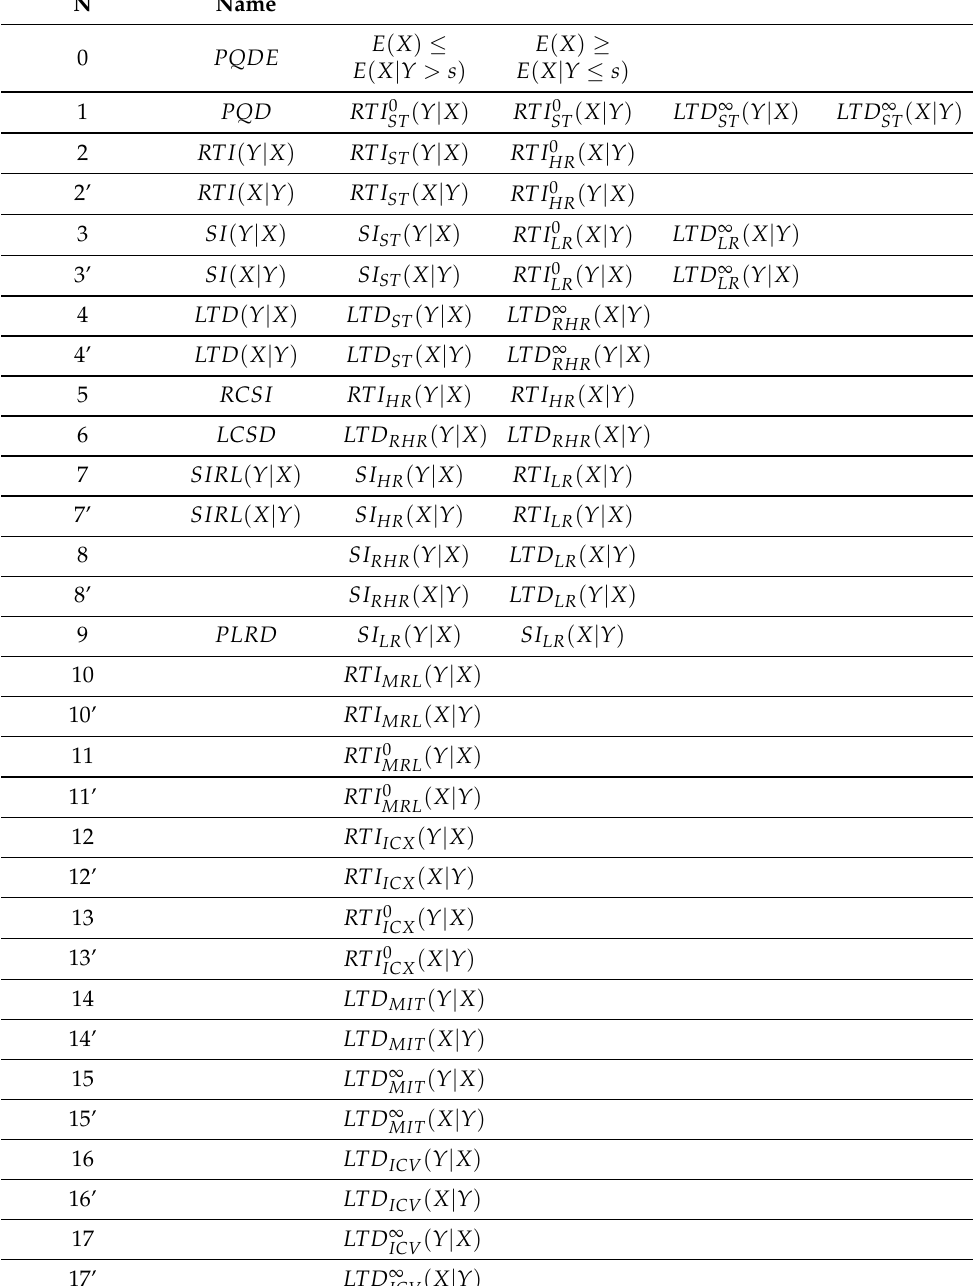
Table 9. Positive dependence